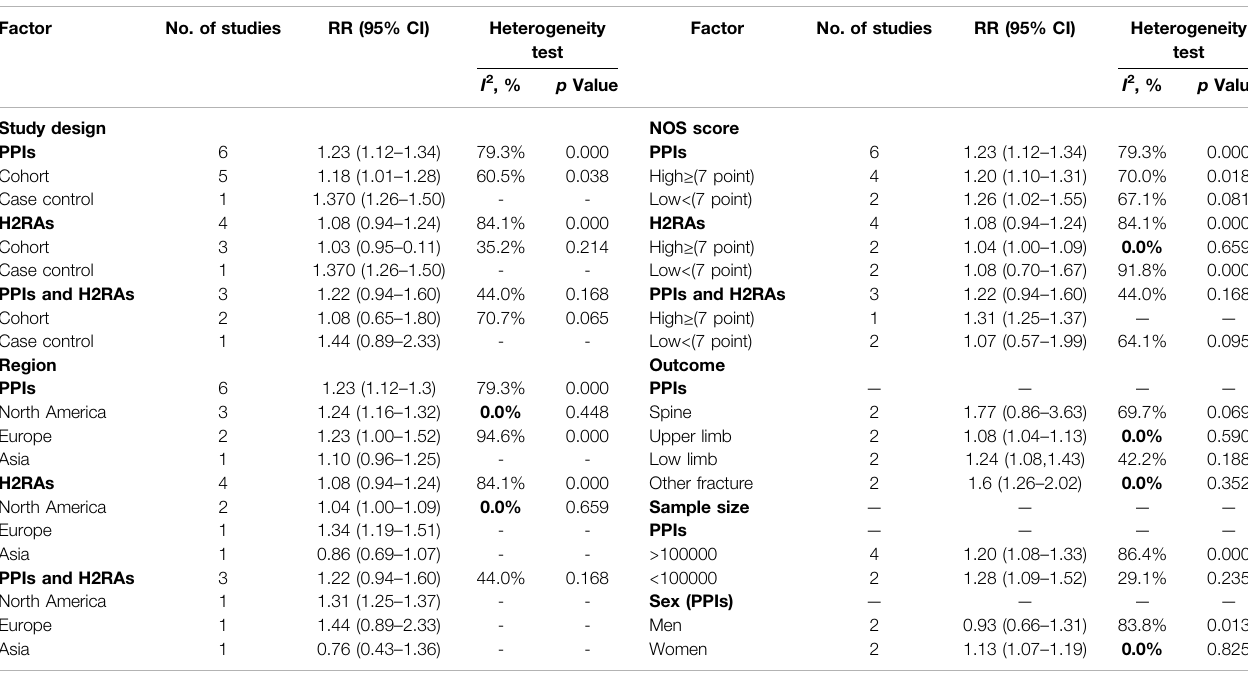
TABLE 2 | PPIs, H2RAs, or PPIs combined with H2RAs use and the risk of fracture in subgroup meta-analyses using a random-effects model.